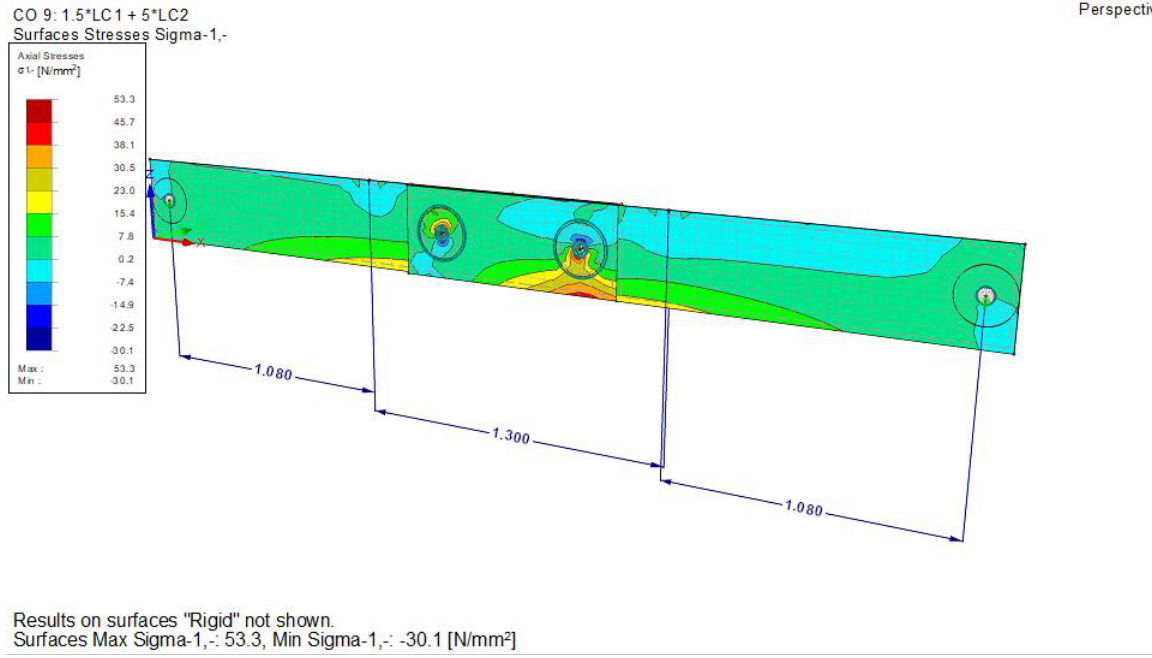
Fig. 6 Analytical model of tested splice.